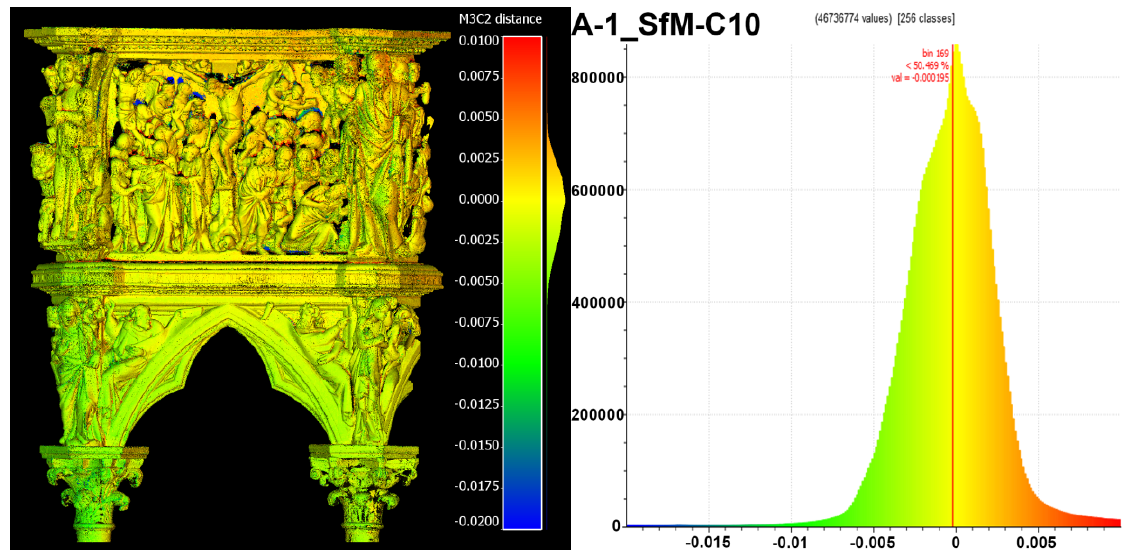
Figure 6 . SfM - C10 comparison and histogram.